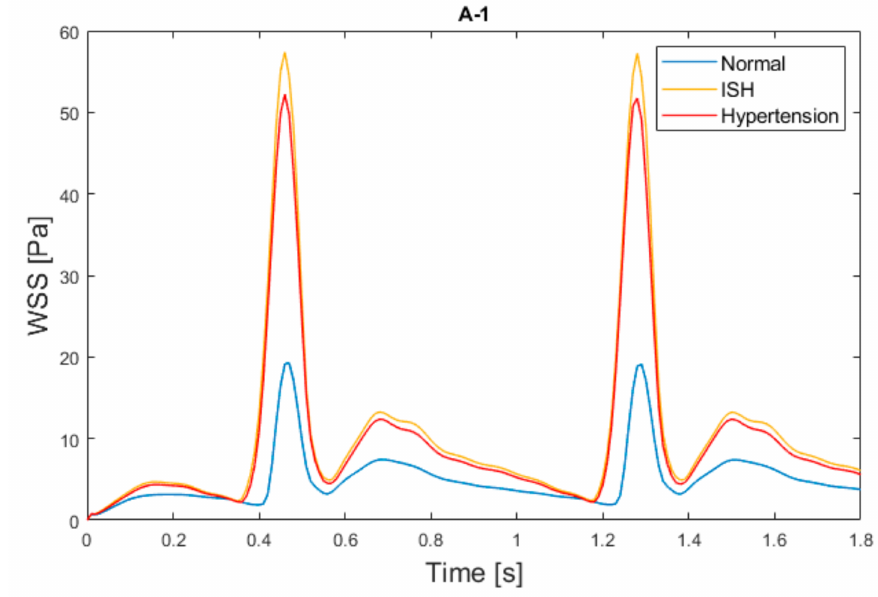
Figure 8. WSS for A-1 model at aneurysm surface and at the entire cardiac